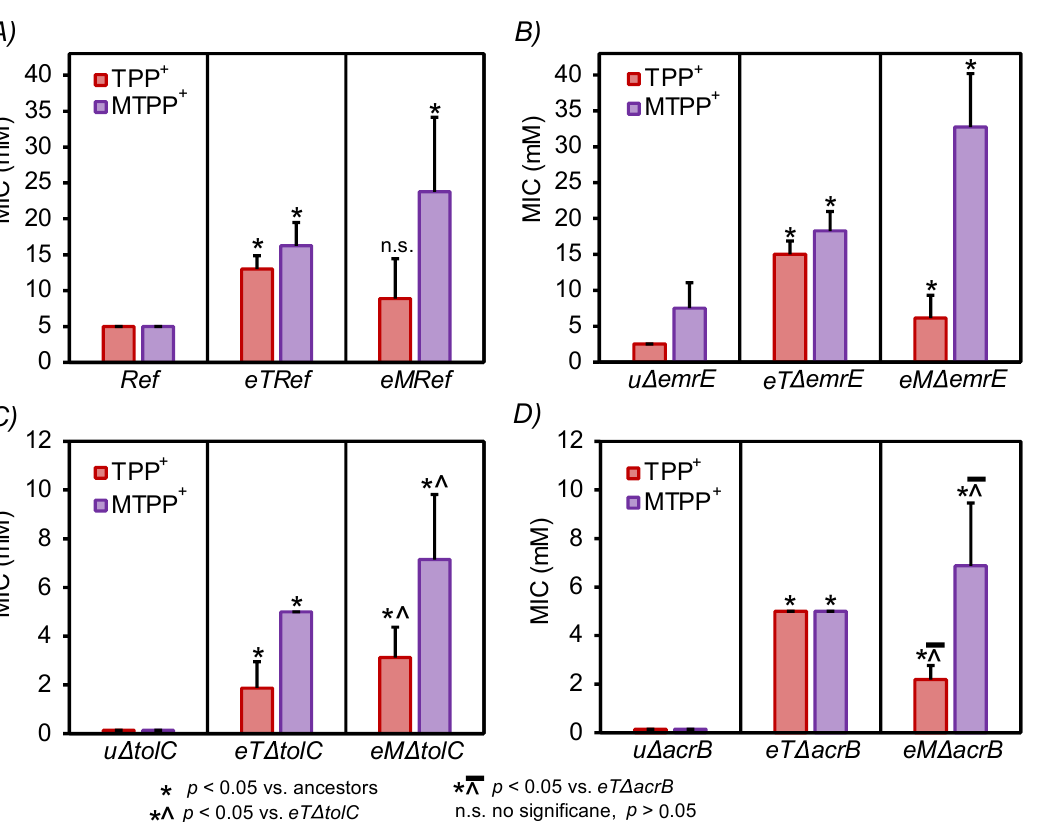
Figure 3. Validation of tolerance phenotypes and cross-cation resistance of the evolved strains. Depicted are the average MIC values (mM) of both TPP + (red bars) and MTPP + (violet bars) experienced by the evolved strains versus their respective ancestors. Strains were tested in the respective cation toward which they were evolved (to confirm tolerance phenotype) and tested separately on the alternative cation toward which they weren’t evolved (to test cross-cation resistance). ( A ) MICs of eTRef and eMRef compared to their ancestor, ‘Ref’ . ( B ) MICs of eT Δ emrE and eM Δ emrE compared to their ancestor, u Δ emrE . ( C ) MICs of eT Δ tolC and eM Δ tolC compared to their ancestor, u Δ tolC . ( D ) MICs of eT Δ acrB and eM Δ acrB compared to their ancestor, u Δ acrB. MIC was determined as the lowest concentration at which less than 10% growth was detected relative to the growth in the basic M9 medium without the addition of either cation. Error bars represents standard deviation ( n = 4). Symbols above the bars indicate statistcal significance between groups ( *): p < 0.05 vs. ancestors, (^): p < 0.05 vs. eT Δ tolC, ( ⊼ ): p < 0.05 vs. eT Δ acrB , and (n.s.): no statistical significance p > 0.05 (Mann-Whitney U test).